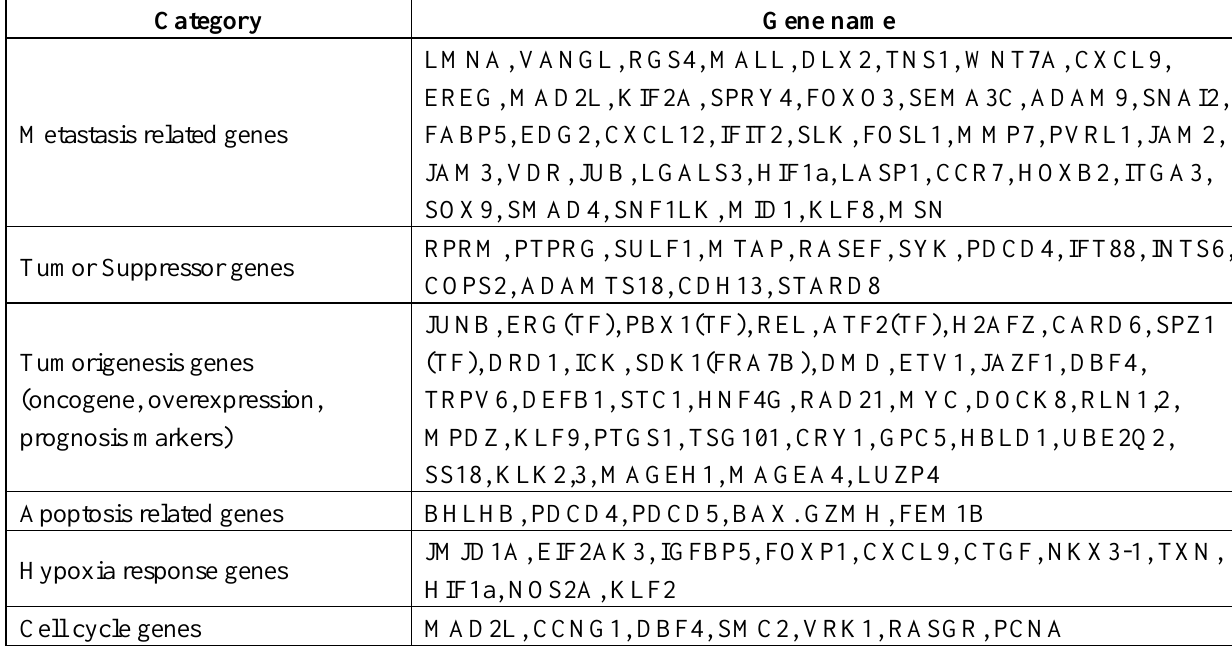
Table 1. Genes differentially methylated between the FaDu and FaDu-HIF1a cell